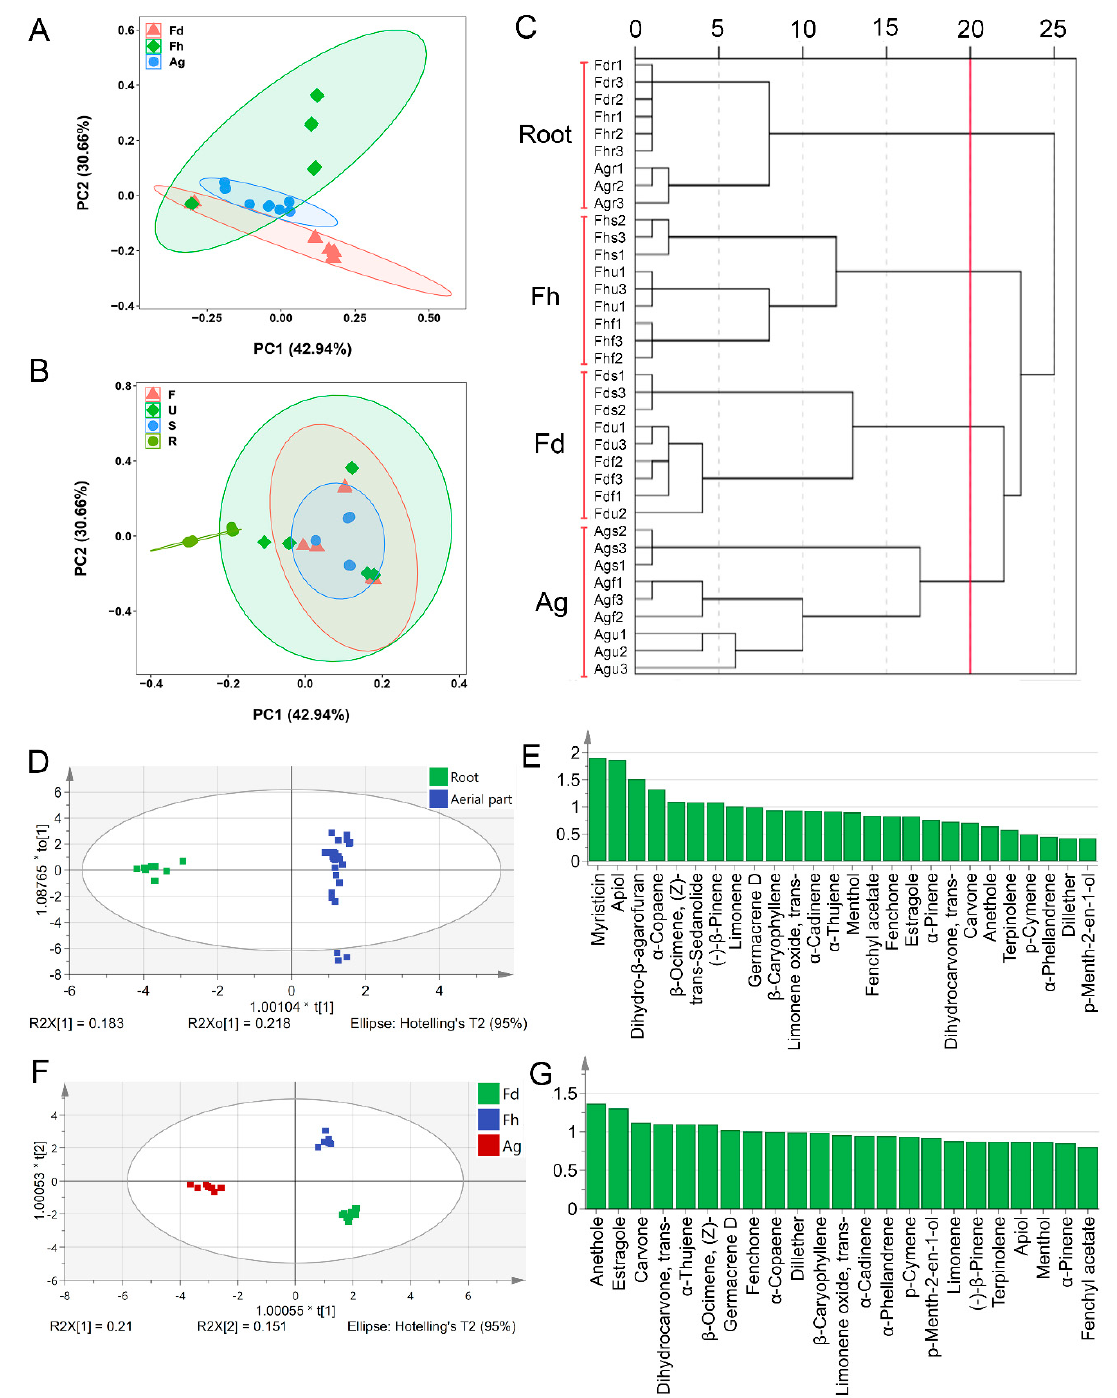
Figure 6. PCA map ( A , B ), dendrogram ( C ), score plots ( D ), and VIP values ( E ) from OPLS-DA analysis based on the chemical profiles of roots and aerial parts. Score plots ( F ) and VIP values ( G ) from OPLS-DA analysis based on the chemical profiles of three species (except for the roots).